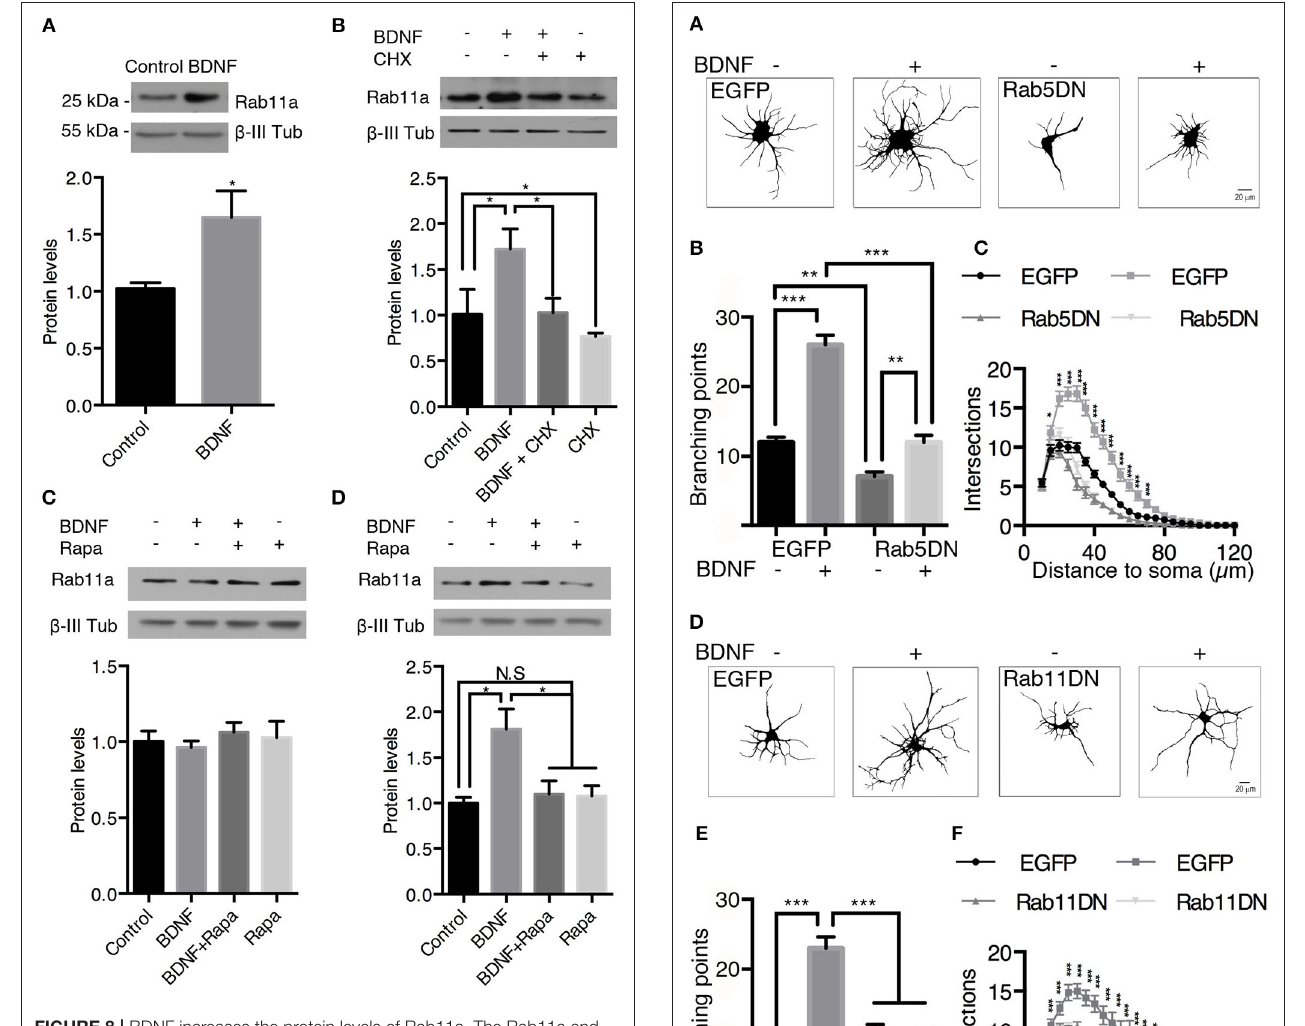
FIGURE 8 | BDNF increases the protein levels of Rab11a. The Rab11a and ß-III tubulin levels in hippocampal neurons (9 DIV) stimulated with BDNF for 24h (A) in the presence or absence of cycloheximide (CHX) (B) . Bottom panel, densitometric quantification of the Ra5a levels normalized to the ß-III tubulin levels. The data represent 5 independent experiments. The results are expressed as the mean ± SEM. * p < 0.05; ** p < 0.01 by ANOVA with Bonferroni’s posttest. (C,D) Ra11a levels after 4h (C) or 12h (D) of treatment with rapamycin (Rapa) in the presence or absence of BDNF. Bottom panel, densitometric quantification of the Ra11a levels normalized to the ß-III tubulin levels. The data represent 4 independent experiments. The results are expressed as the mean ± SEM. * p < 0.05 by ANOVA with Bonferroni’s posttest.